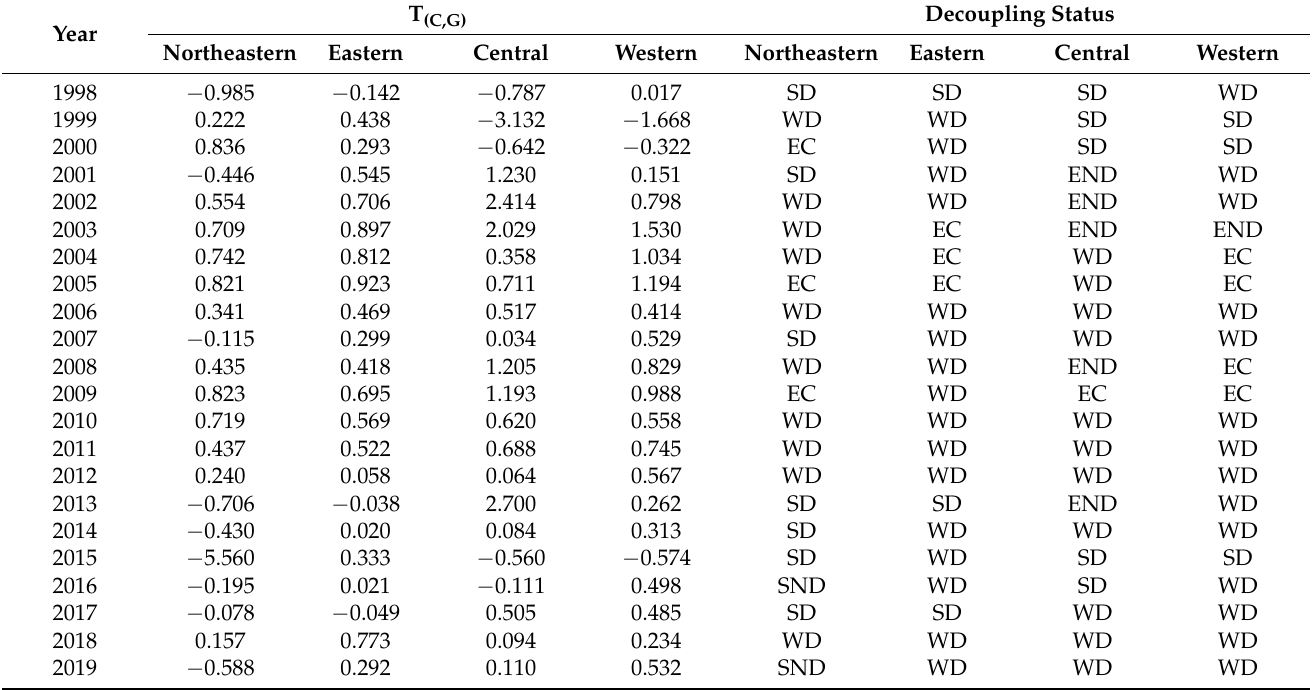
Table 3. Decoupling of carbon emissions and economic growth in four economic regions.